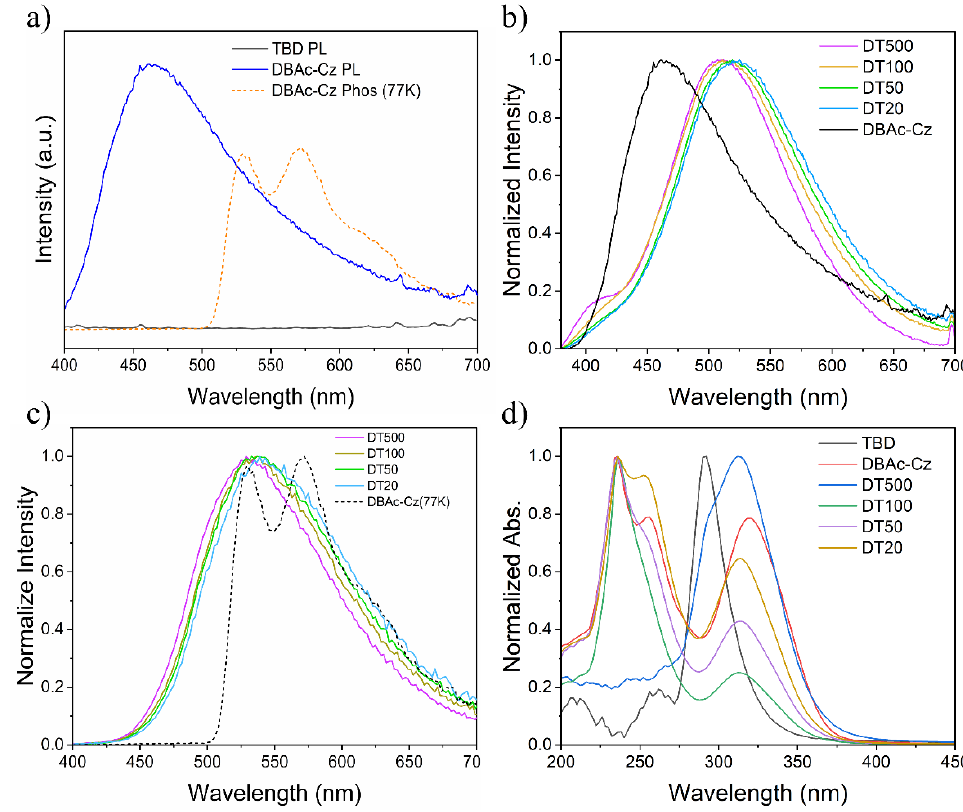
Figure 2. Photoluminescence characterization and UV-vis absorption spectra. ( a ) Steady-state PL spectra (solid line) of TBD and DBAc-Cz, phosphorescence spectra (delay 50 ms) at 77 K (dash line) of DBAc-Cz. ( b ) Normalized steady-state PL spectra of DT500, DT100, DT50, DT20, and DBAc-Cz. A continuous xenon lamp was used as the excitation light source. ( c ) Normalized phosphorescence spectra at room temperature (RTP) for DT500, DT100, DT50, DT20 and phosphorescence spectra at 77 K for DBAc-Cz. A pulse xenon lamp was used as the excitation light source. ( d ) Normalized UV-vis absorption spectra of TBD, DBAc-Cz, DT500, DT100, DT50 and DT20 in dichloromethane (DCM) solution. Table 1. Photophysical properties of the components and